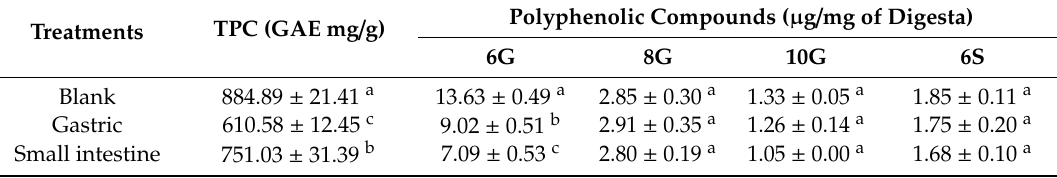
Table 1. Total polyphenolic content (TPC) and major polyphenolic compounds of ginger extract (GE) under simulated gastric and intestinal digestion. All data are expressed as the mean ± SEM. Statistica analysis was performed using